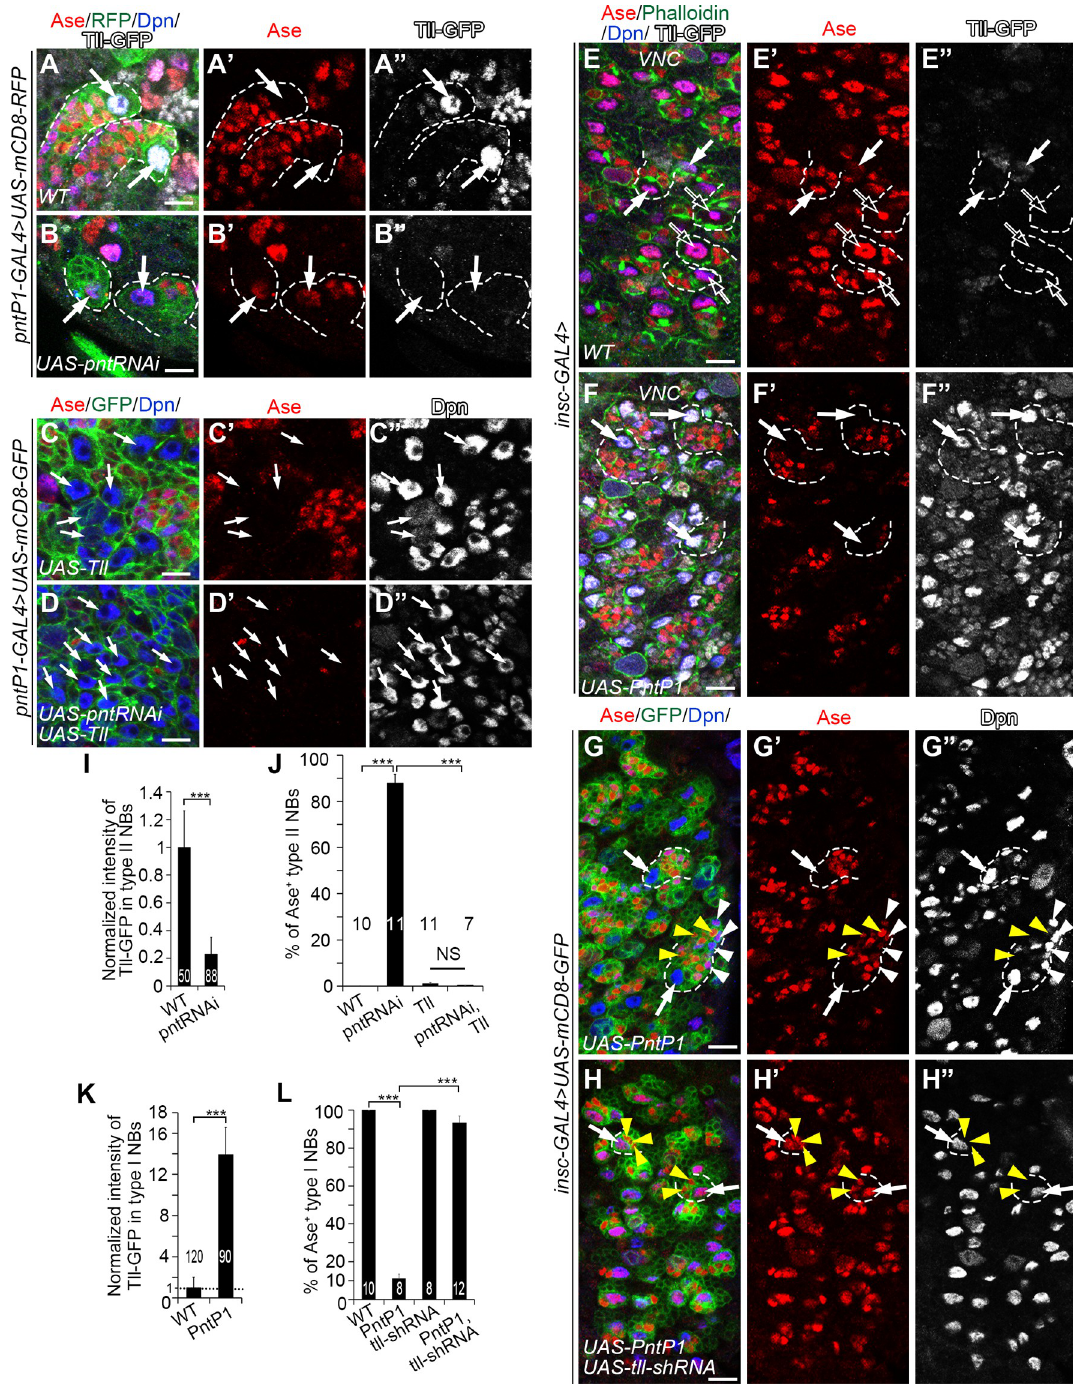
Fig 4. Tll is the PntP1 downstream effector that represses Ase expression in type II NBs. In all images, white arrows point to some representative type I NBs or type II NBs. Dashed lines outline some type I NB or type II NB lineages. White arrowheads point to some Ase + Dpn + mINP-like cells and yellow arrowheads point to some Ase + Dpn - GMCs as examples. Type II NB lineages in the brain are labeled with mCD8-RFP or mCD8-GFP (in green) driven by pntP1-GAL4 and type I NB lineages in the VNC are labeled with Phalloidin or mCD8-GFP (in green) driven by insc-GAL4 . The brains/VNCs are counterstained with anti-Ase (in red), anti-Dpn (in blue) and/or anti-GFP (in white) antibodies. Scale bars equal 10 μ m. (A-B”) Tll is specifically expressed in wild type type II NBs, which are Ase - (A-A”), while knockdown of PntP1 leads to the abolishment of Tll expression and ectopic Ase expression in type II NBs (B-B”). (C-D”) Expressing UAS-Tll in type II NBs results in generation of supernumerary type II NBs, which are Ase - (C-C”),